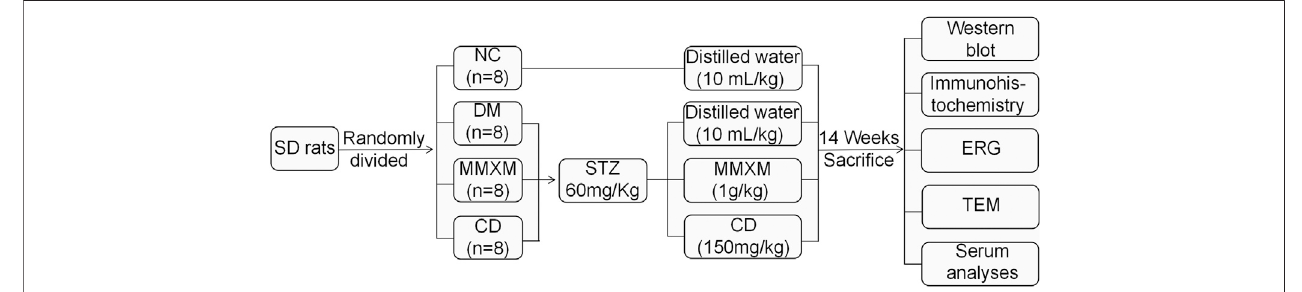
FIGURE 1 | Animal experimental